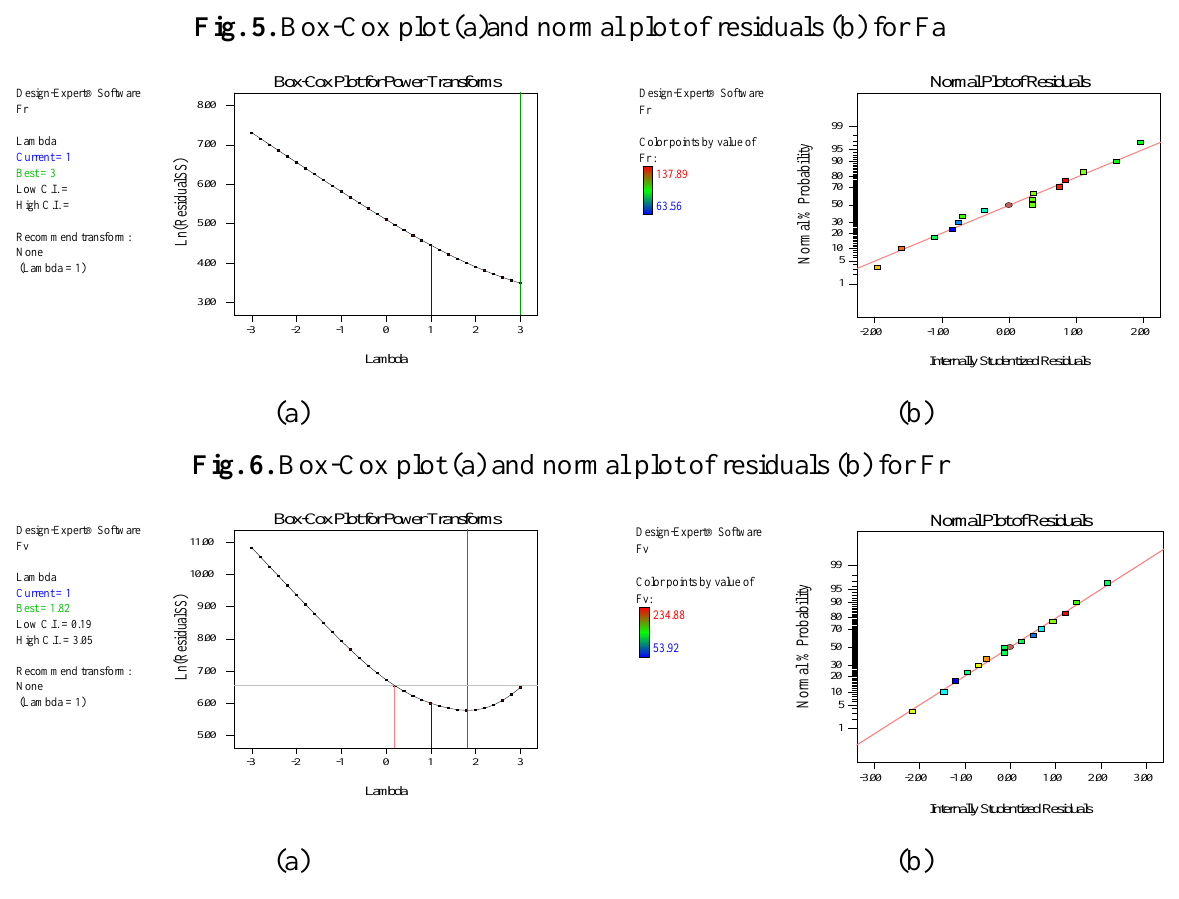
Fig.7. Box-Cox plot (a) and normal plot of residuals (b) for